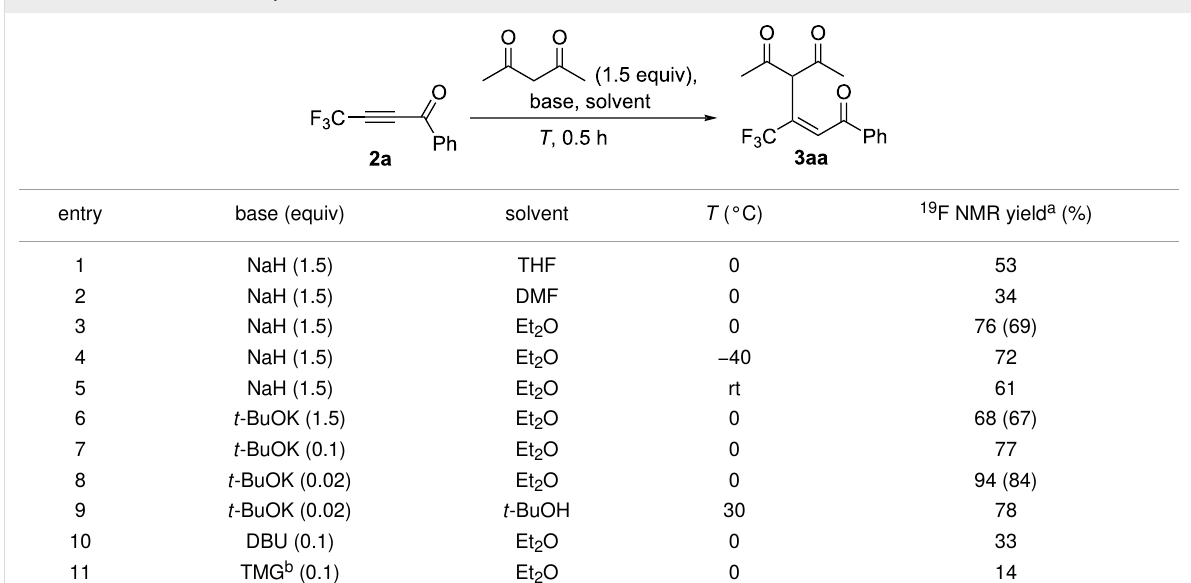
Table 2: Michael addition of acetylacetone to 2a .